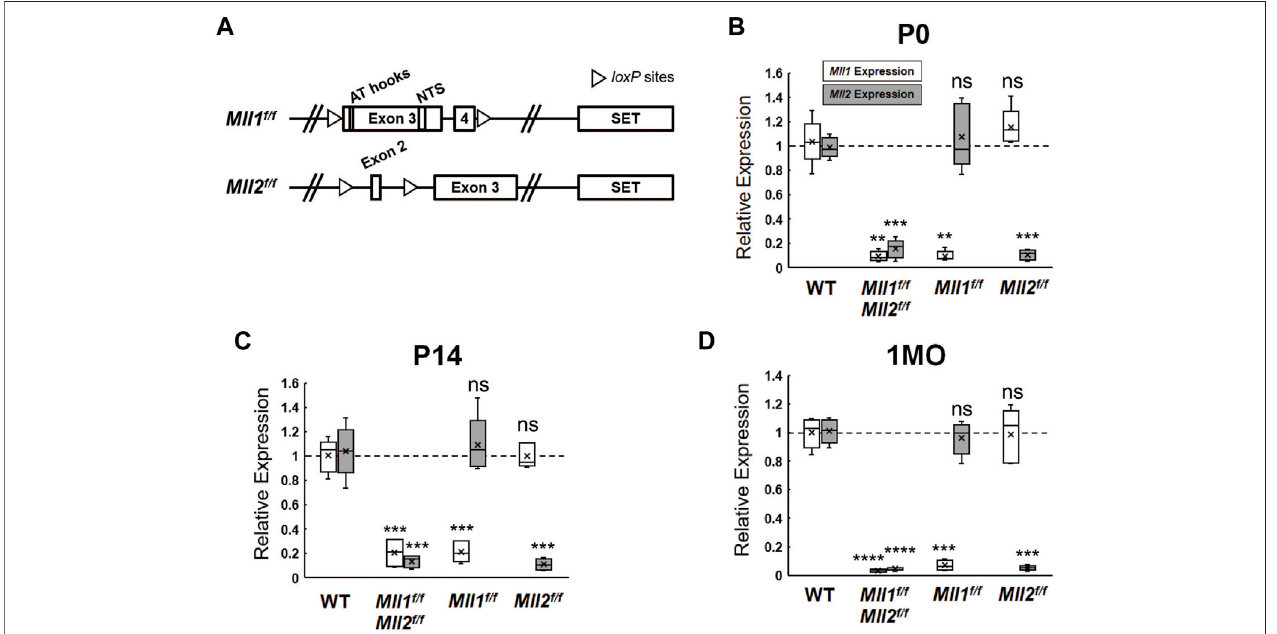
FIGURE 1 | Mll1 and Mll2 expression in conditional-knockout retinae. (A) Diagrams of wide-type Mll1 and Mll2 genes indicating the positions of SET domains, motifs and loxP sites. Cre recombinase-mediated Mll1 knockout removes exons 3 and 4 which encode the motifs of AT hooks and nuclear targeting signals (NTS) (Gan et al.,2010).Crerecombinase-mediated Mll2 knockoutremovesexon2andinvokesaframeshift inthemRNA(Glaser etal.,2006). (B – D) qRT-PCRanalysisof Mll1 and Mll2 expression in P0, P14 and 1 month-old (1MO) mutant retinae. Results are plotted as relative expression to Chx10Cre - littermate controls ( n = 5). Asterisks (**, ***, ****) denote p ≤ 0.01, p ≤ 0.001, p ≤ 0.0001 respectively by one-way ANOVA with Tukey ’ s multiple comparisons, and ns means not signi fi